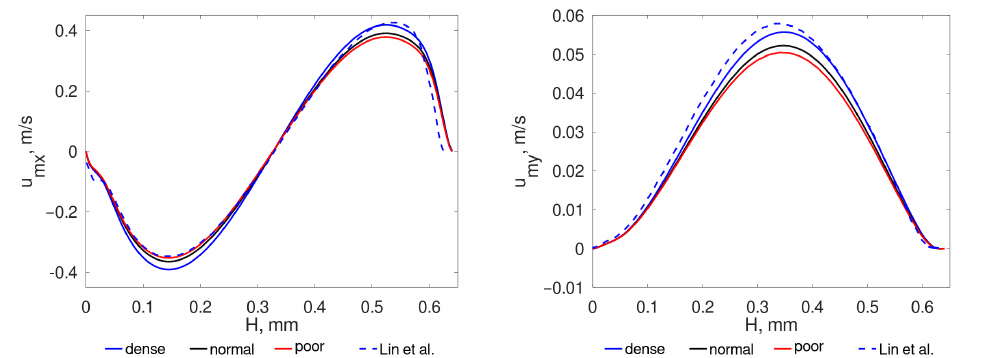
Figure 2. Comparison of the x and y components of streaming velocity u mx and u my for various mesh resolution with the results from [4]; ( Left ): Plots of u mx along H of the resonator for x = 0.75 L; ( Right ): Plots of u my along H of the resonator for x = 0.5